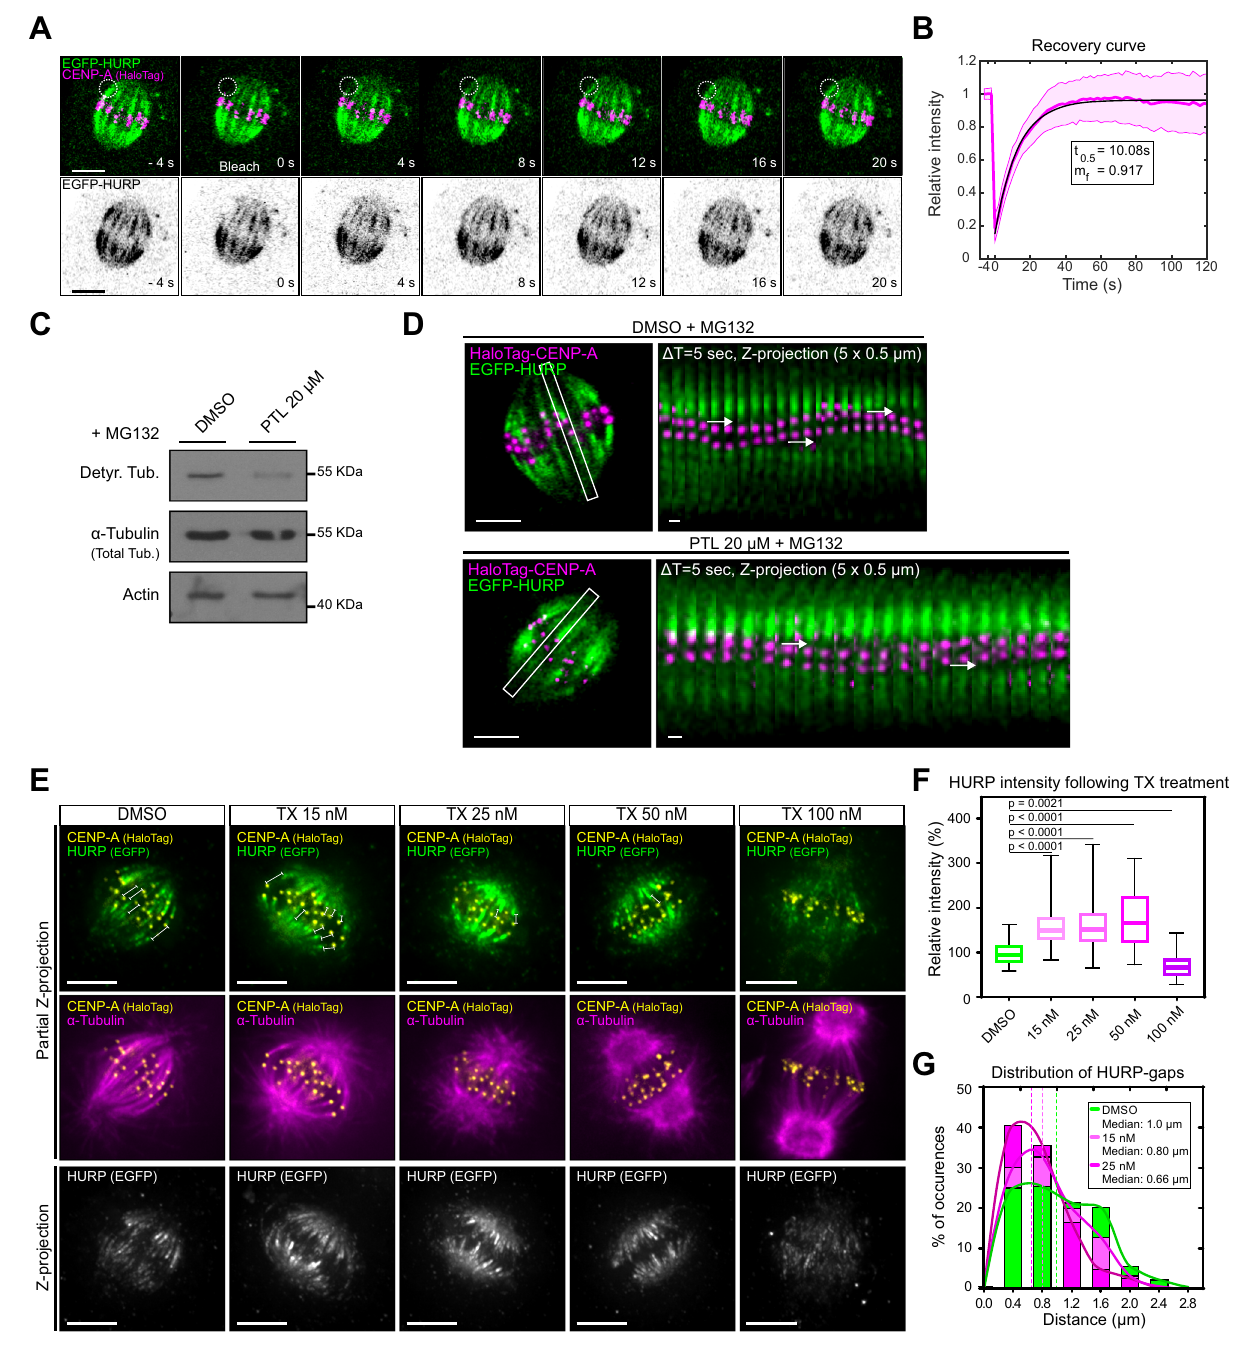
Fig. 3 | HURP-gaps are precisely linked to K- fi bre conformation. A FRAP time- lapse of hTERT-RPE1 EGFP-HURP/HaloTag-CENP-A cell. Inset indicates bleached region on single K- fi bre. B EGFP-HURP FRAP recovery curve. Data are presented as mean values±SD. Black line= fi t of mono-exponential recovery ( N =4, n =47 K- fi bres). C WesternblotanalysisofdetyrosinatedtubulinlevelsinhTERT-RPE1-EGFP- HURP/HaloTag-CENP-A protein extracts of cells blocked in metaphase (10 µ M MG132)andco-treatedwithDMSOor20 µ MParthenolide(PTL). D Live-cellimaging of hTERT-RPE1 EGFP-HURP/HaloTag-CENP-A cell blocked in metaphase treated with DMSO or 20 µ M Parthenolide (PTL). Inset shows sister K- fi bre pair used for kymograph (right panel), arrows indicate the HURP-gaps. E Immuno fl uorescence images of metaphase hTERT-RPE1-EGFP-HURP/HaloTag-CENP-A cells treated with